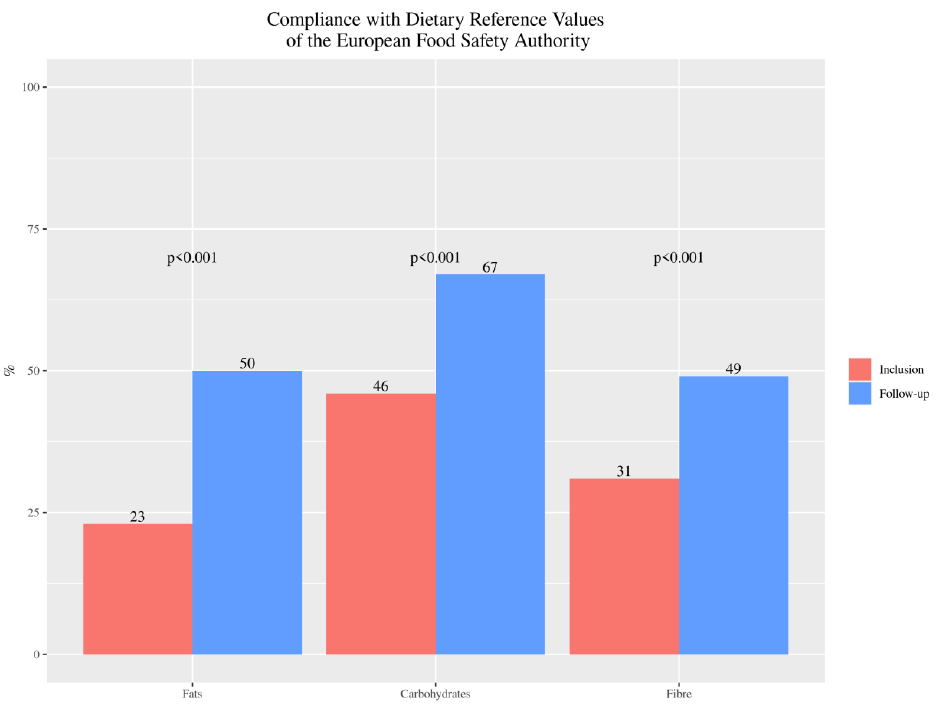
Figure 1. Percentage of celiac disease (CD) pediatric patients’ compliance with the recommendations for fats, carbohydrates (expressed in percentage) and fiber (expressed in g/day) intake, from baseline (inclusion) to twelve months after nutrition education (follow-up).